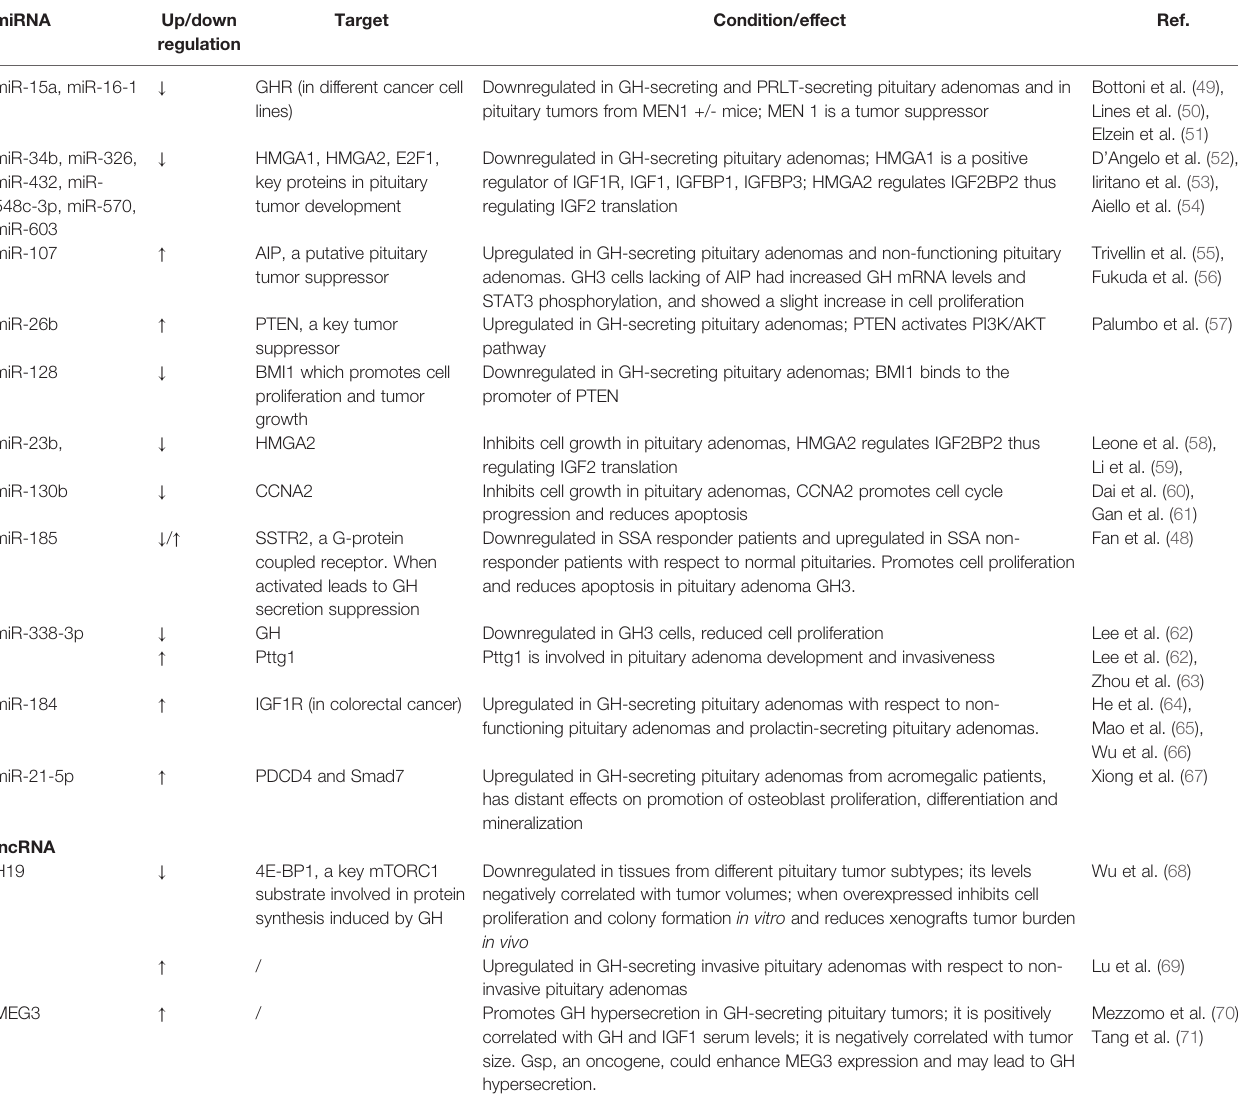
TABLE 1 | Current knowledge on the role of miRNAs and lncRNAs on the GH/IGF1 axis and IGF system in pituitary adenomas. miRNA Up/down regulation